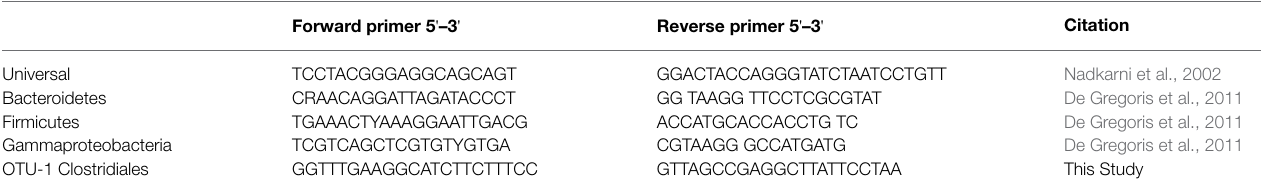
TABLE 1 | Quantitative PCR (qPCR) primers utilized in this